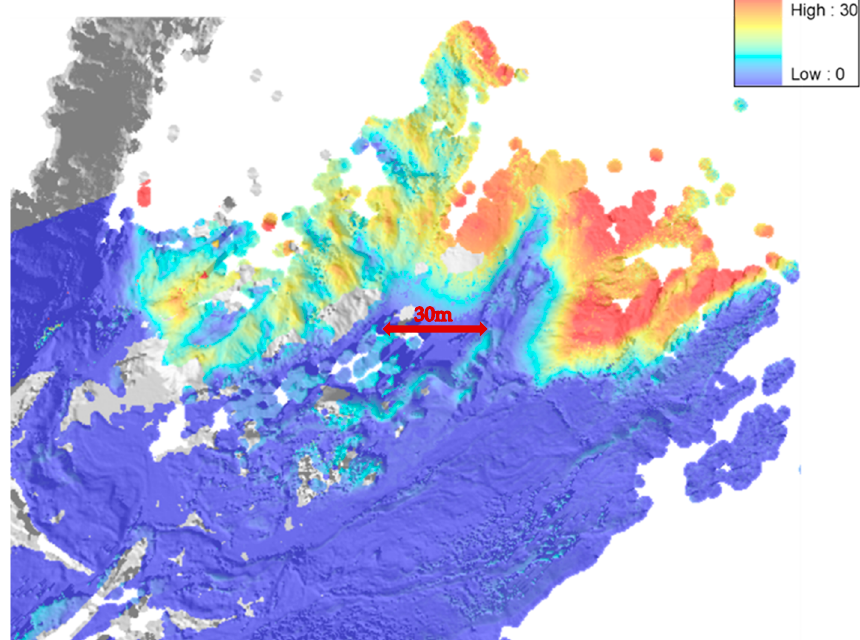
Figure 9. Falljökull glacial margin; change detection model: 2009 to 2012.